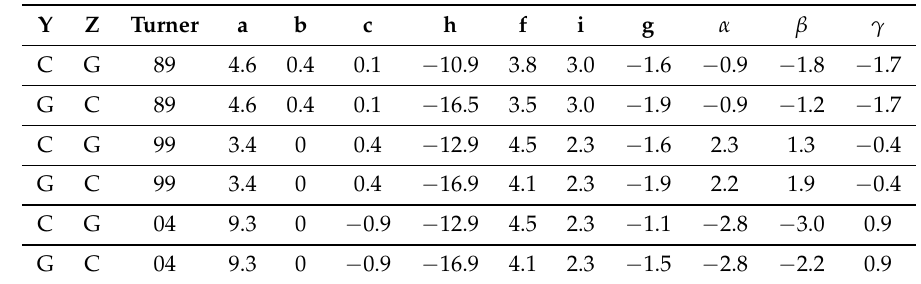
Table 1. Nearest Neighbor Thermodynamic Model (NNTM) parameters and resulting energy functions. Energy functions are of the form α d 0 + β d 1 + γ r